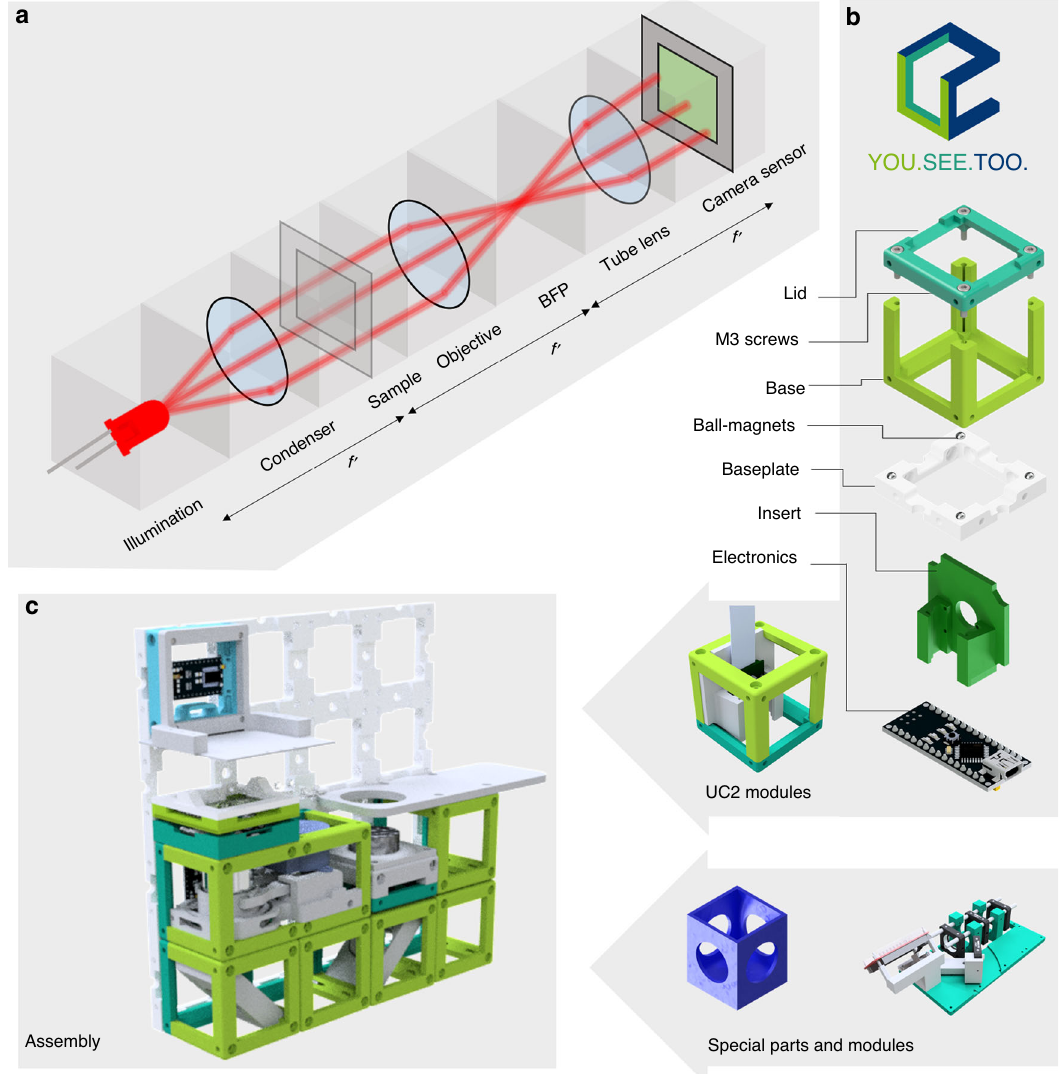
Fig. 1 Optical Setup using UC2 Optical Building Blocks. a The 4 f -system divides Fourier-optical arrangements into functional units, where f 0 corresponds to the focal-lengths. BFP corresponds to the back focal plane (i.e. pupil plane). b The unit element (cube) acts as a base framework for any component which fi ts inside (lens, camera, Z-autofocusing mechanism, etc.). b A magnetic snap- fi t mechanism connects the optical building blocks to a skeleton to realize mechanical stability and rapid-prototyping of a given optical setup. c An exemplary setup of a microscope for an ordinary smartphone (not shown) and an inexpensive objective as a combination of available modules. The cubes fi t on the baseplate grid at 50 × 50 mm 2 design pitch (see Supplementary Notes